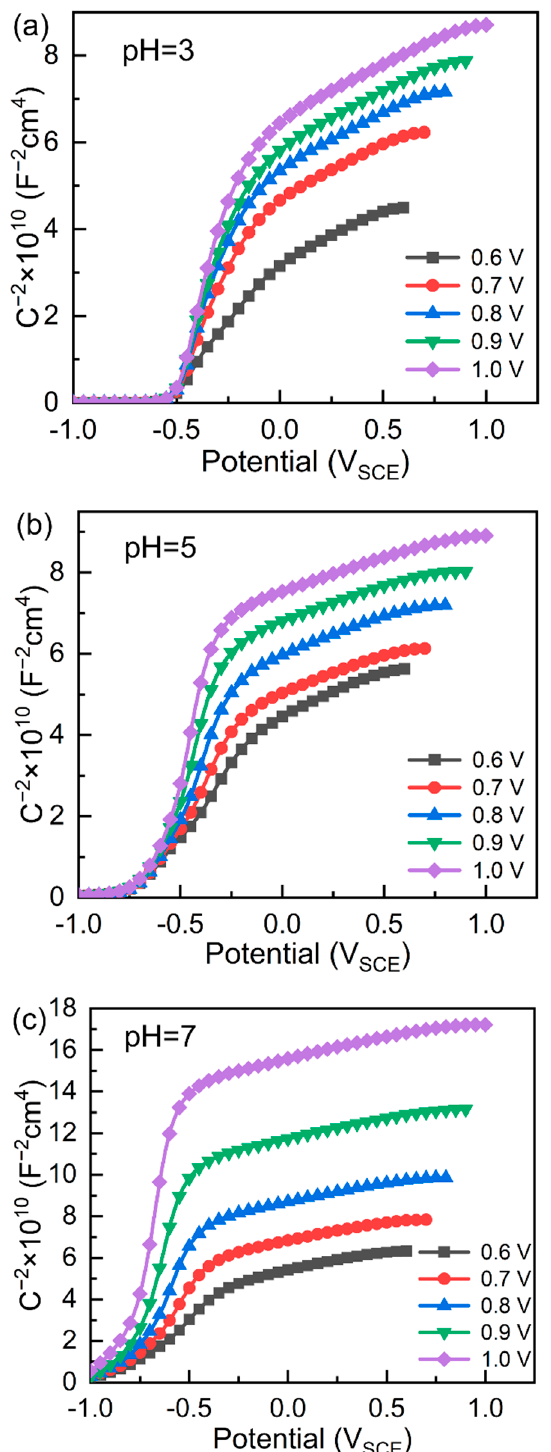
Figure 6. Mott–Schottky curves of potentiostatic polarized LPBFed Ti–6Al–4V in Hank’s solution, under the potentials of 0.6, 0.7, 0.8, 0.9, 1.0 V SCE , at ( a ) pH 3, ( b ) pH 5, and ( c ) pH 7.